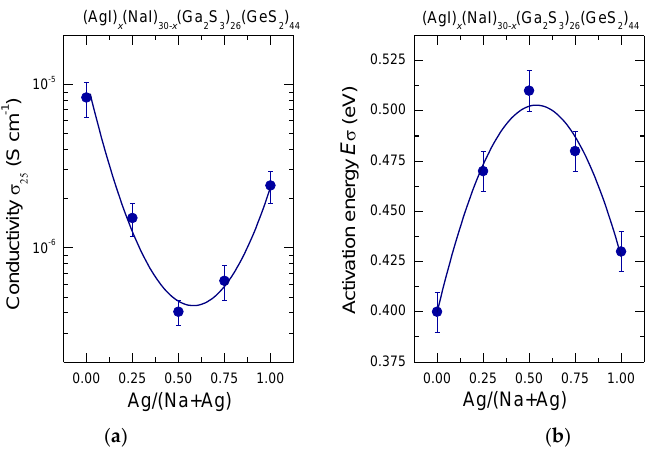
Figure 6. ( a ) Room-temperature conductivity σ 25 and ( b ) conductivity activation energy E σ for the (AgI) x (NaI) 30 − x (Ga 2 S 3 ) 26 (GeS 2 ) 44 glasses plotted as a function of the silver fraction r = Ag/(Na + Ag). The solid lines are drawn as a guide for the eye.